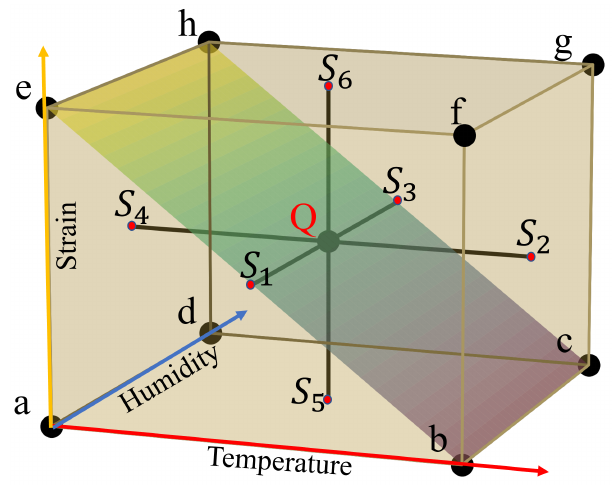
Figure 1. The experimental cube domain in a three-factor two-level factorial design.